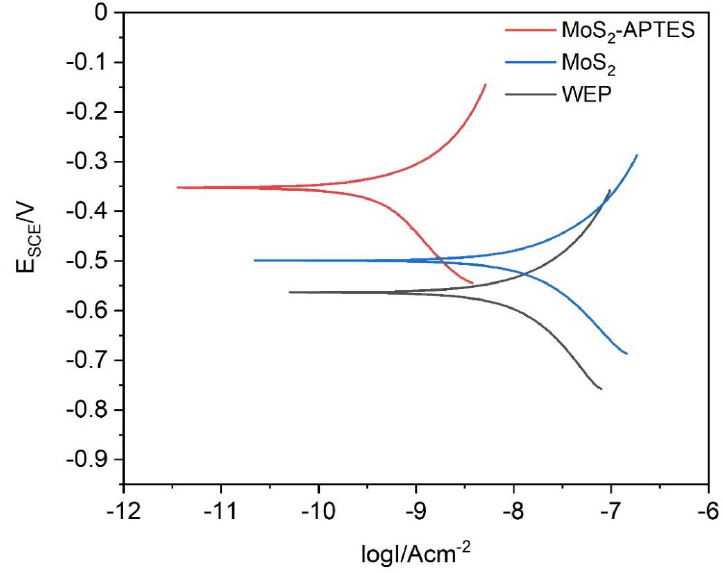
Figure 9. The polarization curves of composite coatings after in 3.5 wt.% NaCl solution for 50